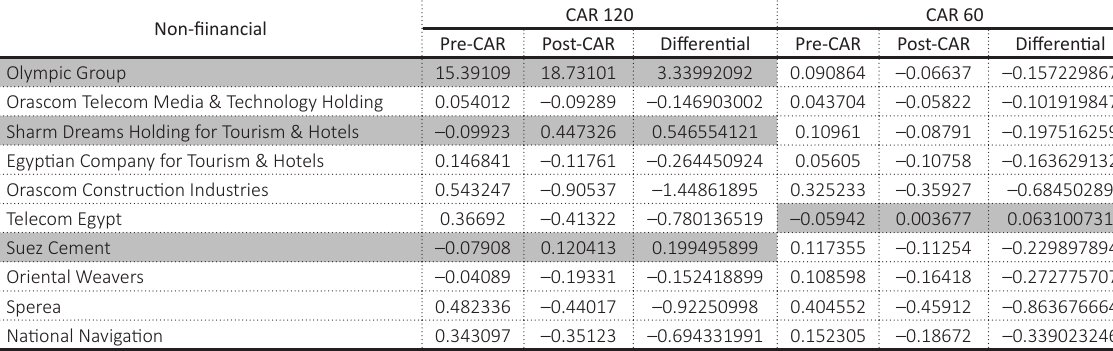
Table 3. Differential analysis between CAR 120 days and CAR 60 days for M&A